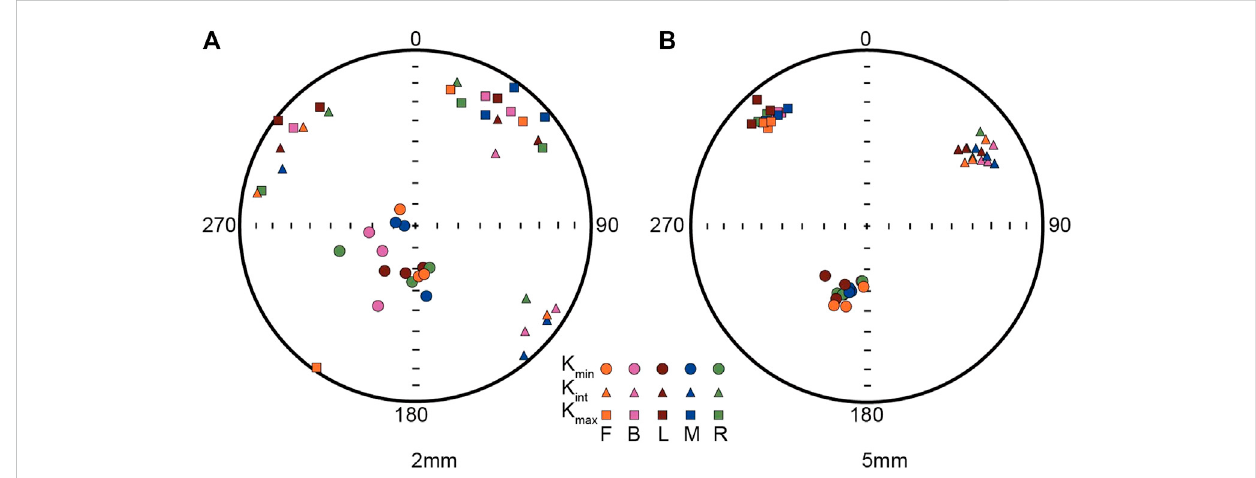
FIGURE 5 Equal-area projections of the three principal axes of AMS results measured at different positions (left, right, back, forth, and middle shown in Figure 3B) for 2-mm (A) and 5-mm (B) cubes. Specimens were measured three times at each position.